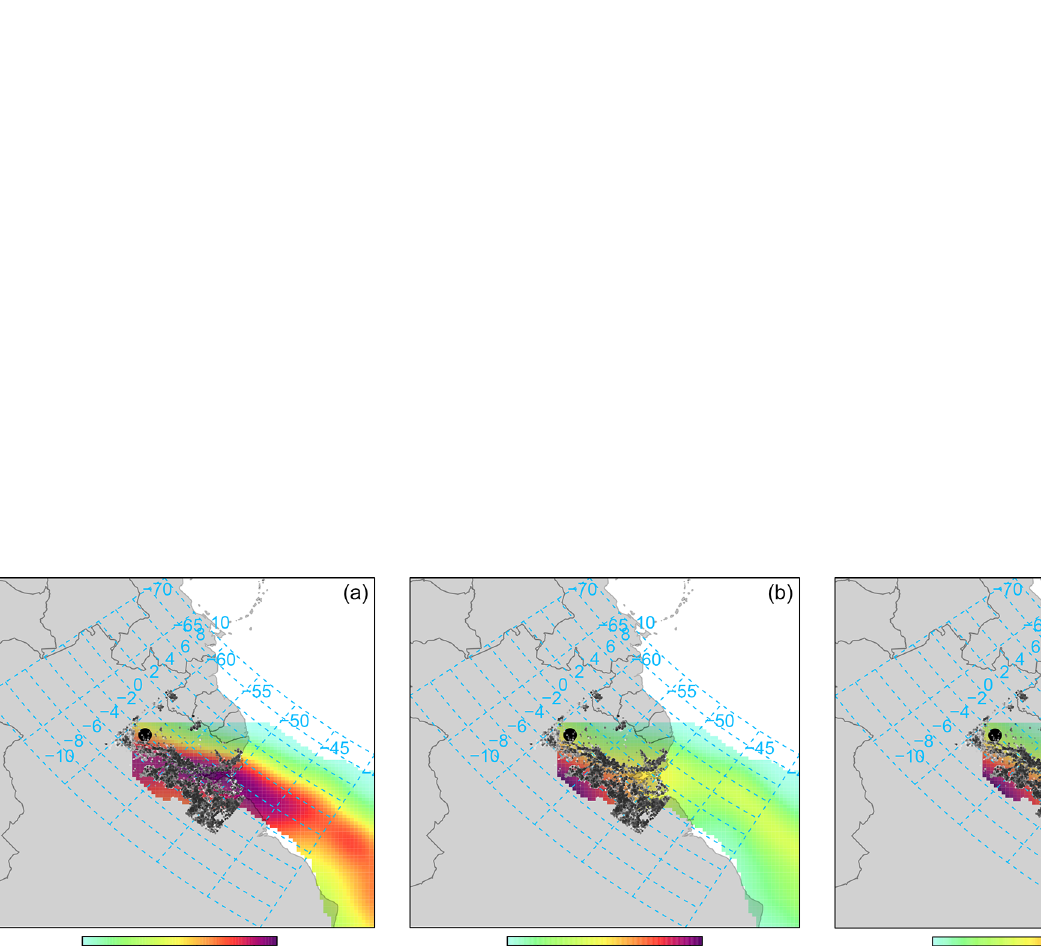
and NH + , with fire data overlaid. Fire data are coloured 4 4